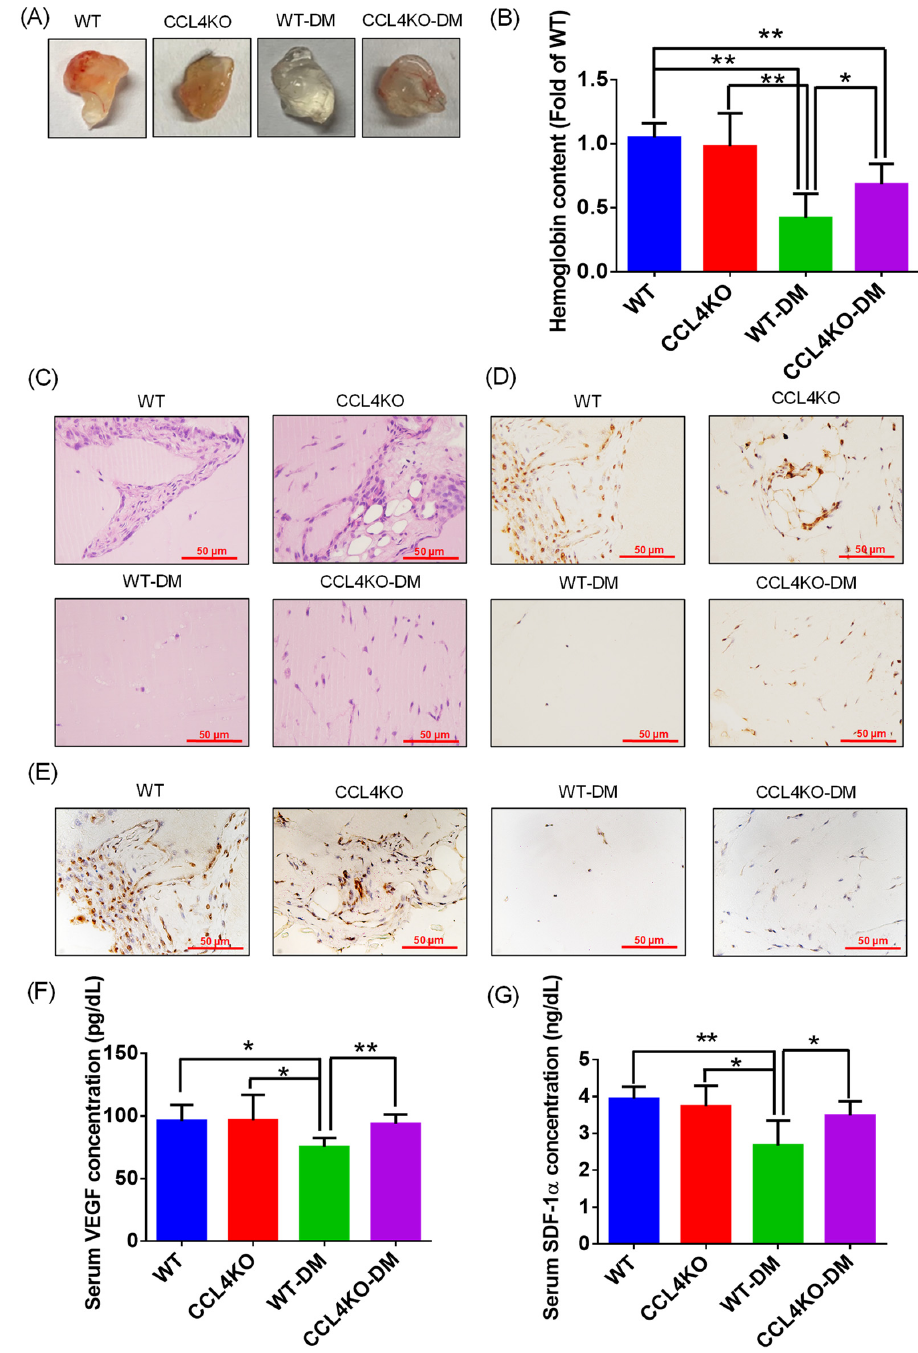
Figure 4. CCL4 inhibition by knockout enhanced neovascularization in diabetic mice. Representative Matrigel plug ( A ) and analysis of hemoglobin content (( B ); n = 6). Representative images with H&E staining ( C ). Representative images with immunostaining of CD31 and Ki67. Both CD31- and Ki67-positive areas were enhanced in the CCL4-knockout mice ( D , E ). Serum concentrations of VEGF and SDF-1 α were higher in the CCL4-knockout diabetic mice than in the wild-type diabetic mice (( F , G ); n = 6). WT, wild-type mice; CCL4KO, CCL4-knockout mice; WT-DM, wild-type diabetic mice; CCL4KO-DM, CCL4-knockout diabetic mice. * p < 0.05, ** p < 0.01.